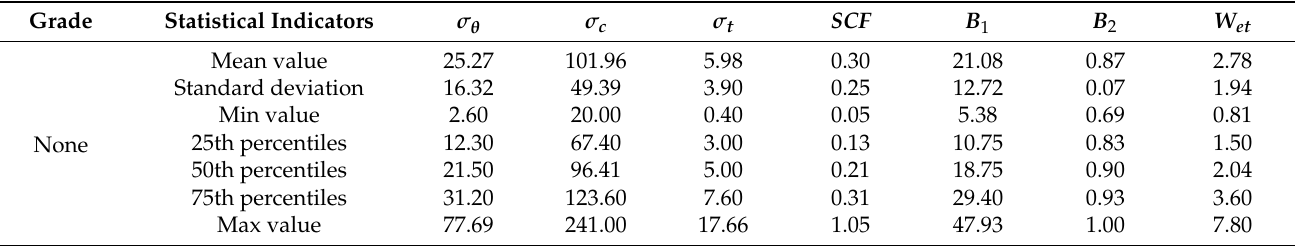
Table 4. Statistical description of the input